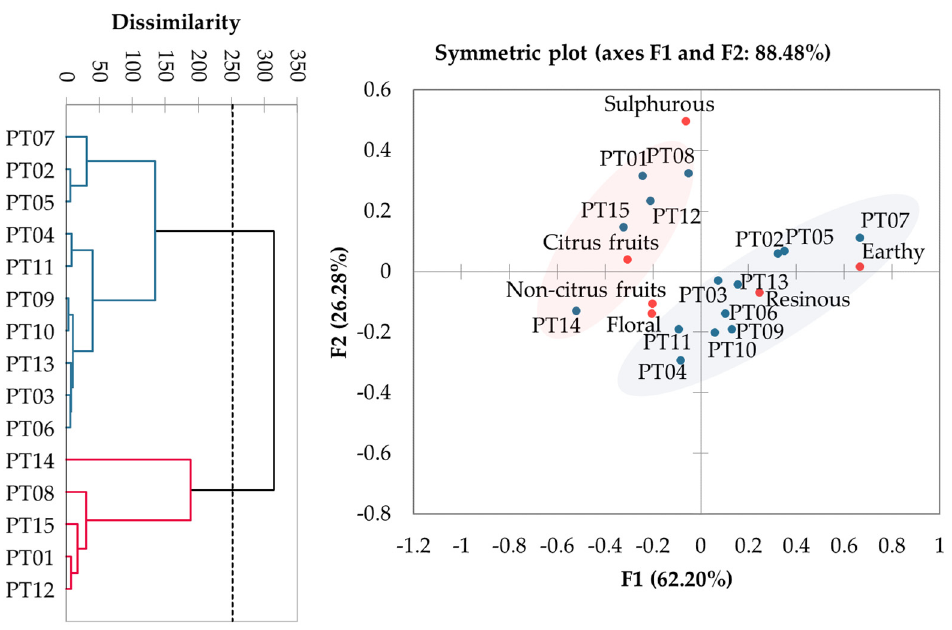
Figure 1. Agglomerative Hierarchical Clustering and Correspondence Analysis of Portuguese wild hops sensory attributes.